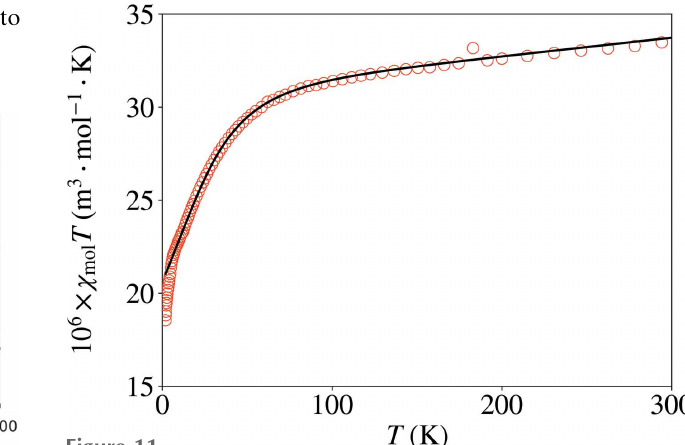
Figure 11 Temperature dependence of (cid:5) T for Co(Phpz)Cl 2 . The solid line is the fit using an exact diagonalization method, between 5 and 310